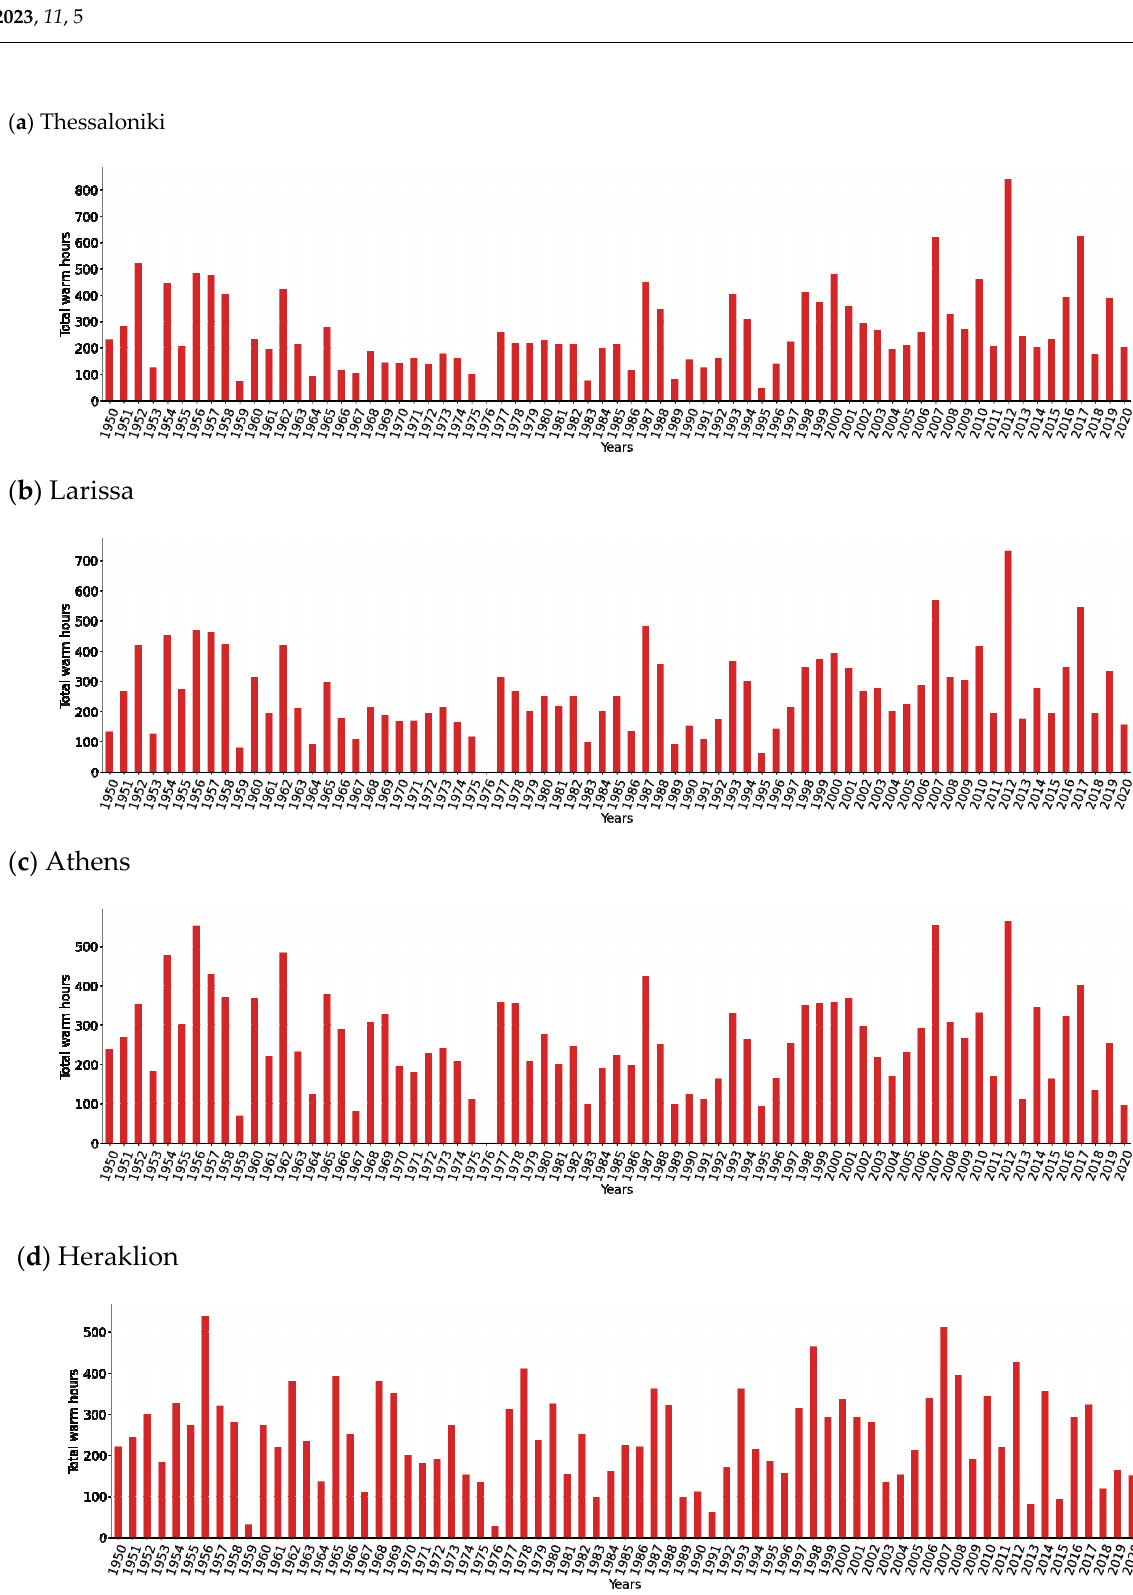
Figure 12. Temporal evolution of warm hours per year calculated from ERA5 (850-hPa tempera- ture) during the period 1950–2020 for four selected cities ( a ) Thessaloniki, ( b ) Larissa, ( c ) Athens, ( d ) Heraklion.